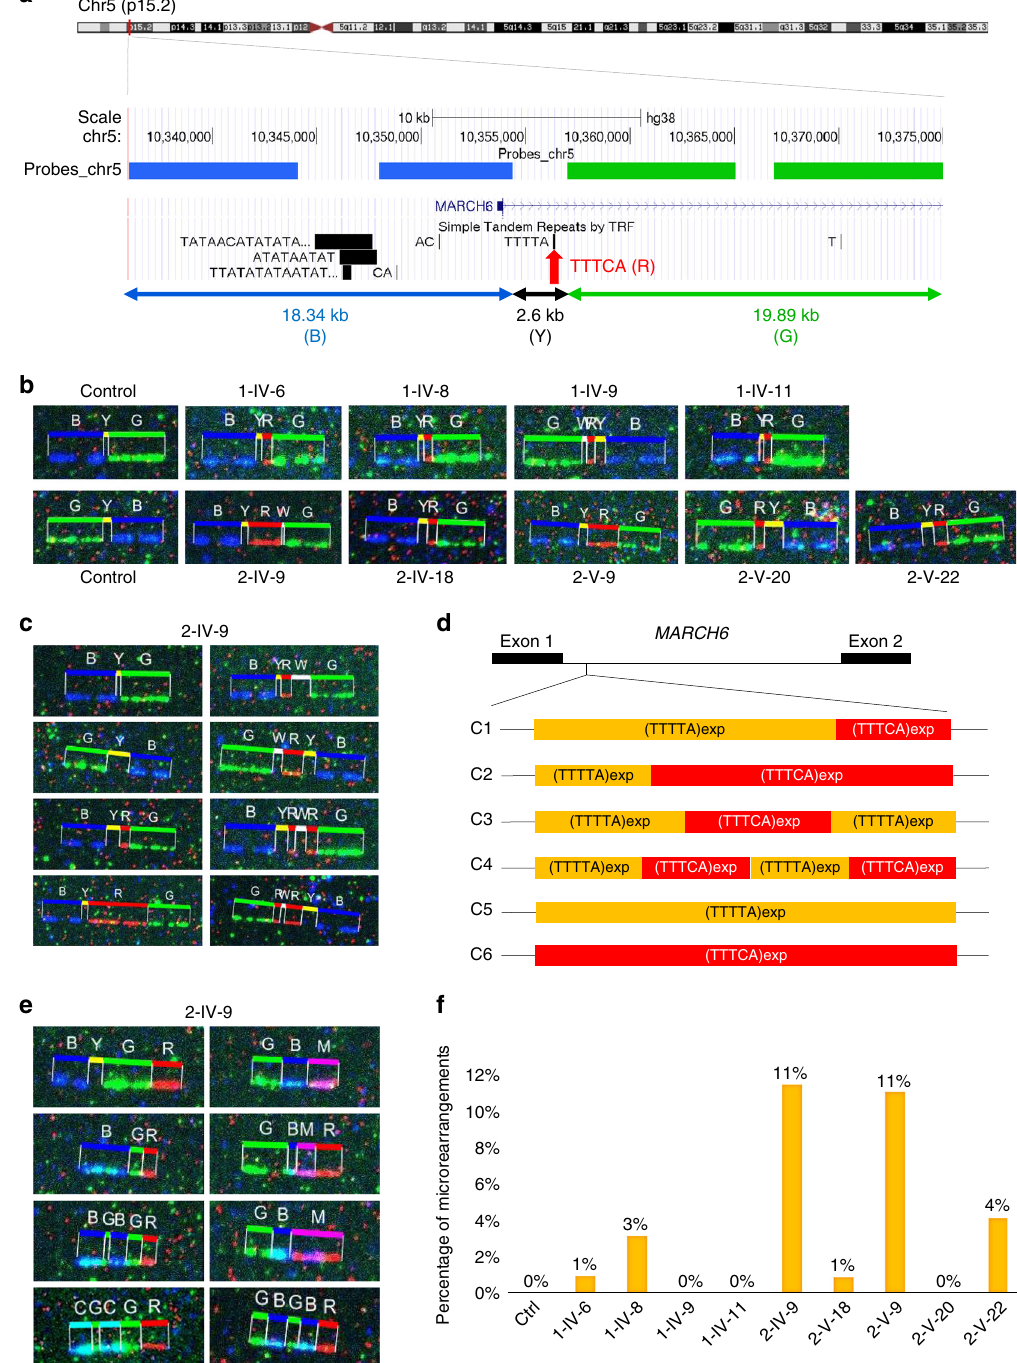
Fig. 4 Somatic mosaicism of MARCH6 expansions detected by molecular combing. a Schematic representation of the molecular code used to stain regions adjacent to MARCH6 expansions. Probes directed against speci fi c 5 ʹ (labeled in blue, B) or 3 ʹ (labeled in green, G) fl anking regions have been hybridized to single-stretched DNA fi bers extracted from blood cells; TTTCA repeats are stained in red (R). b Representative images seen in a control individual (two panels on the left) and in nine expansion carrier individuals for whom molecular combing was performed. Y refers to the unstained part between the blue and red signals; unstained parts detected between the red and green signals or in-between two red signals are referred to as W. c Selected images observed at the expanded site in the proband of Family 2 (2-IV-9), showing extreme variability of the expansion length and structure in his blood. d Schematic representation of the different expansion con fi gurations (C1 – C6) observed using molecular combing. e) Selected micro-rearrangements observed at the expanded site in individual 2-IV-9. M (magenta) and C (Cyan) correspond to the overlay of red and blue or green and blue probes, respectively, indicating an overlap of probes that should normally be separated. All images corresponding to micro-rearrangements observed in individuals 2-IV-9 and 2-V-9 are shown in Supplementary Fig. 10. f Percentage of micro-rearrangements observed in the ten individuals analyzed by molecular combing. Individuals with the largest expansions (2-IV-9 and 2-V-9) exhibit a higher percentage of rearranged alleles than individuals with smaller